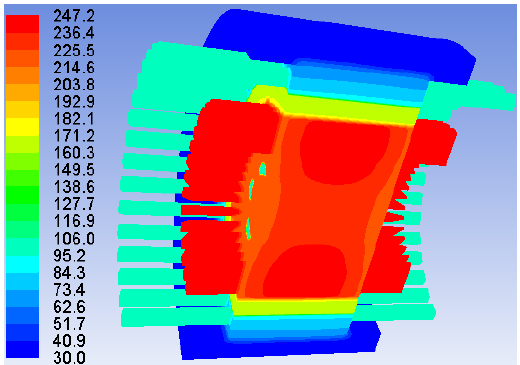
Figure 11. Thermal field distribution under condition of only water cooling used in the casing when both the SM and the DRM are running at the rated speed and load.